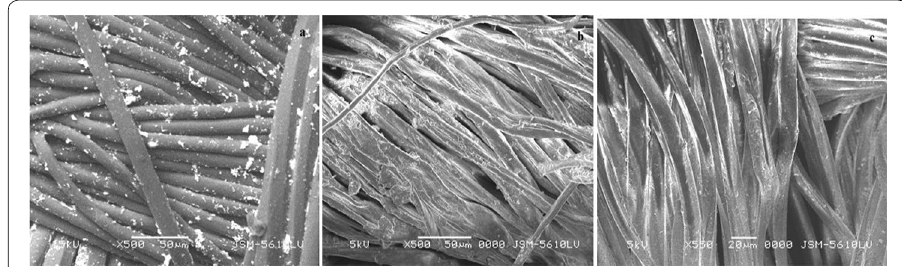
Fig. 4 SEM microphotographs of a polyester b cotton and c polyester-cotton blend fabric with copper nano